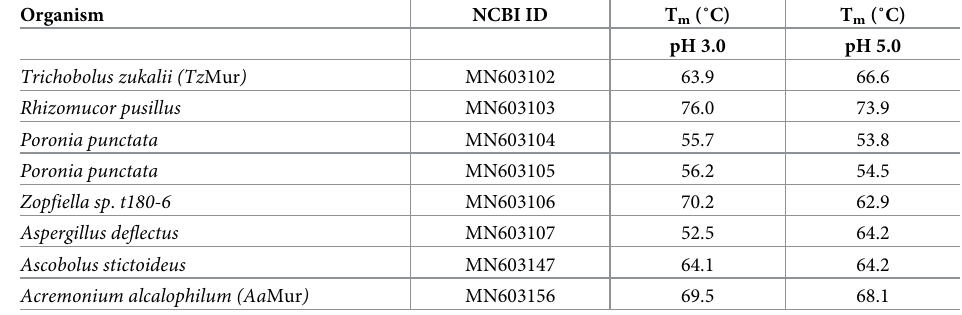
Table 4. The melting points of a subset of the GH25 enzymes determined by nano-differential scanning fluorimetry.